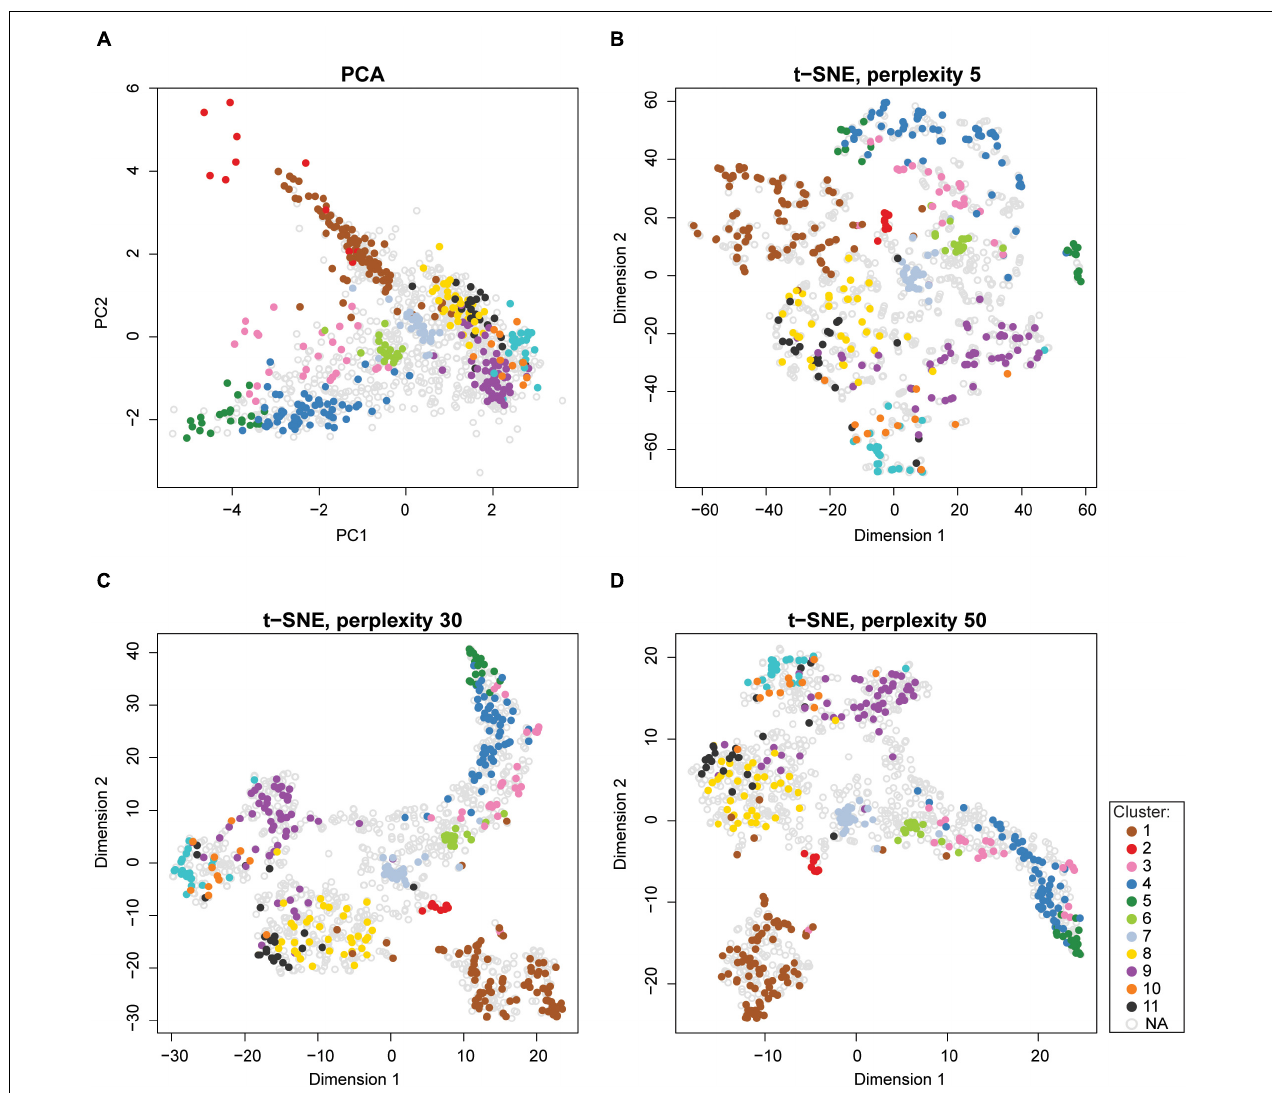
FIGURE 9 | Visualization of high-dimensional spatial proteomics data using PCA and t-SNE. (A) Data can be displayed along principal component values (PCs) of PCA in two or more dimensions. (B–D) Better resolution of clusters can be achieved by t-SNE. However, the results of the t-SNE algorithm depend on the values of its tunable parameters. For instance, the perplexity parameter typically ranges between 5 and 50 (Van Der Maaten and Hinton, 2008). Perplexity settings of 5, 30, and 50 are shown in panels (B–D) . All other parameters were kept constant. Human Embryonic Kidney (HEK293T) sample data from pRoloc package was used for all